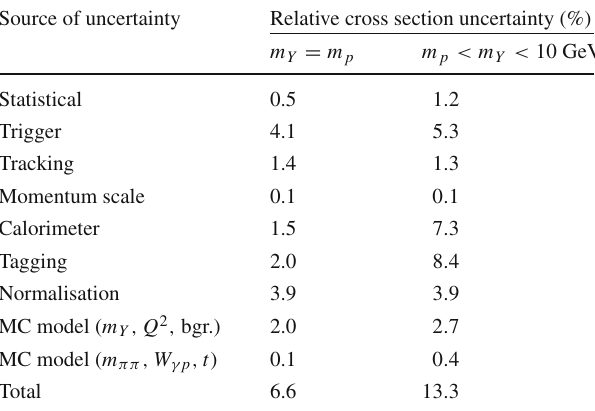
Table 4 Summary of the combined impact of systematic uncertainties on the fiducial π + π − photoproduction cross sections. The numbers are obtained by unfolding the one-dimensional m ππ distribution and with symmetrised systematic uncertainties